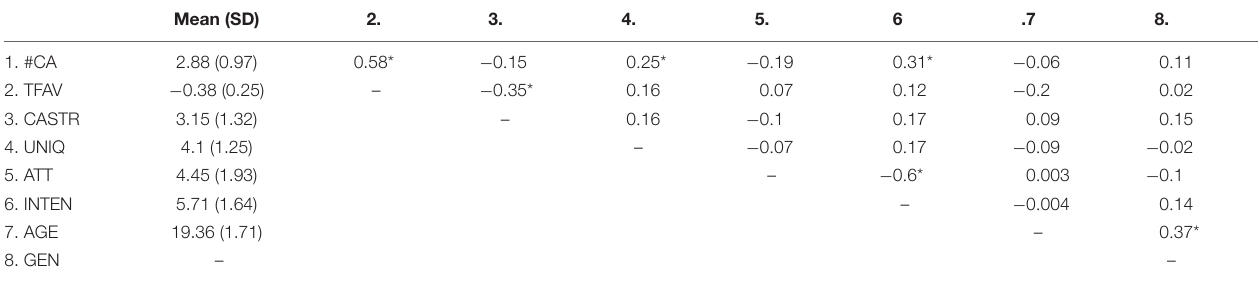
TABLE 1 | Study 1 Descriptive statistics for the variables of